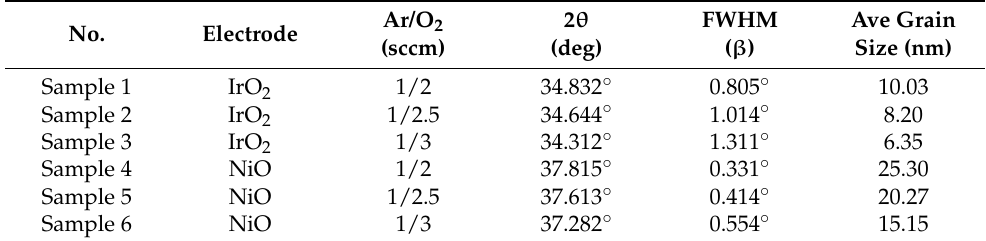
Table 4. Average grain size of IrO 2 and NiO